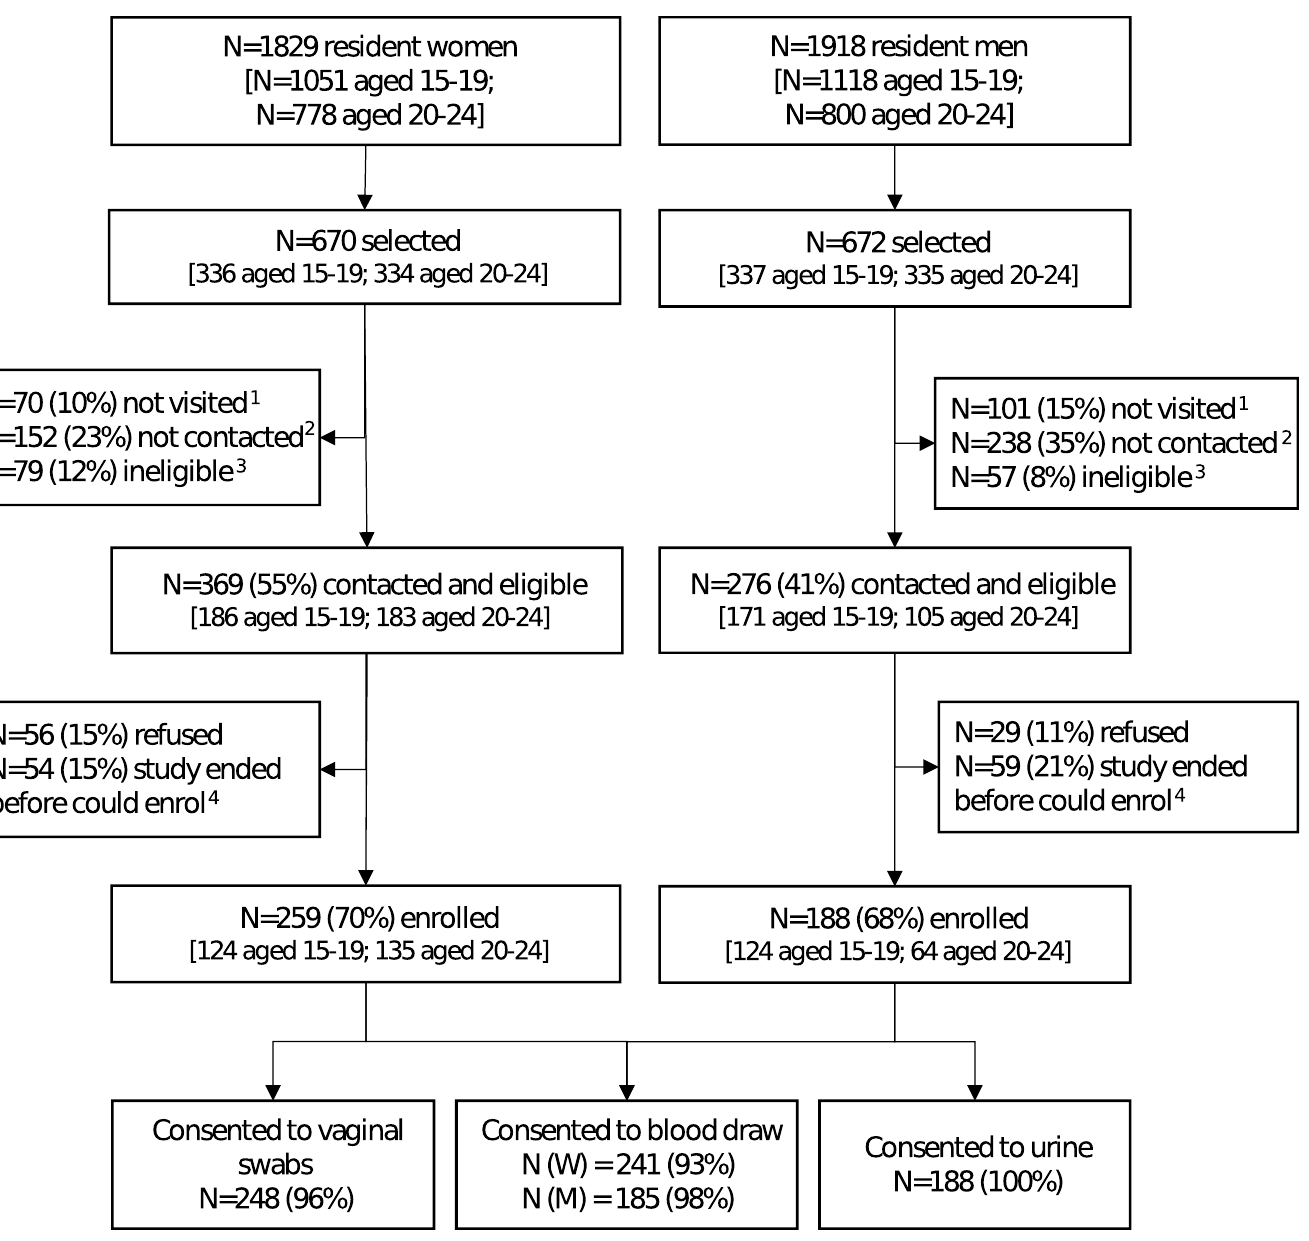
Fig 1. Flow diagram for enrolment in a population-based sexually transmitted infection survey among young people aged 15–24 years in rural Kwa-Zulu Natal. 1 Not visited: no visit was made to the household because the study ended. 2 Not contacted: at least 1 visit was made to the household, but either a parent (if selected individual < 18 years) or the individual was unavailable. 3 Ineligible: individuals who were found to have out-migrated from the health and demographic surveillance site ( N = 73 women and 53 men) or who were not capable of providing consent ( N = 6 women and 4 men). 4 Individuals who were interested in the study, but could not enrol because study